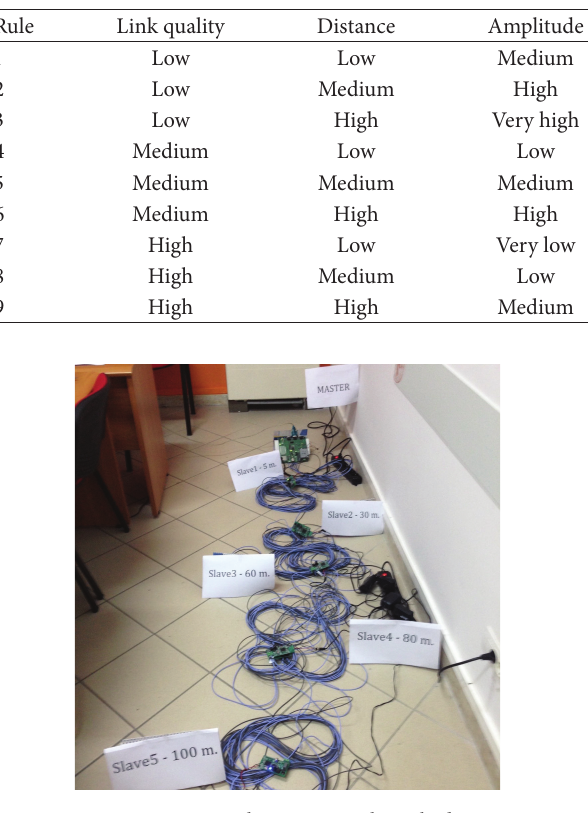
Figure 6: Real experimental test-bed. Table 3: Master-slave